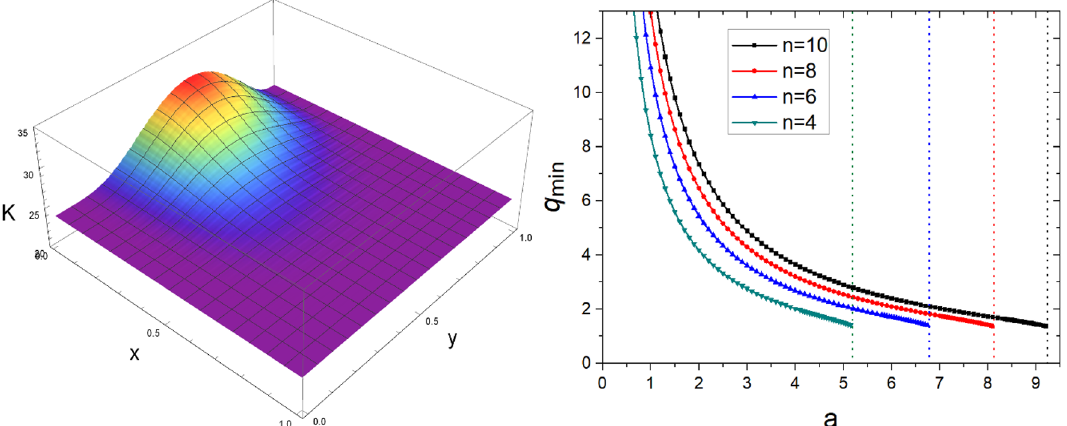
Figure 1 . Left : the distribution of the Kretschmann scalar K over the integrate domain [0 , 1] × [0 , 1] , for a = 5 and n = 8 . Right : the minimal charge q min against amplitude a with fixed λ = 4 and β = 6 , for various profiles n = 10 , 8 , 6 , 4